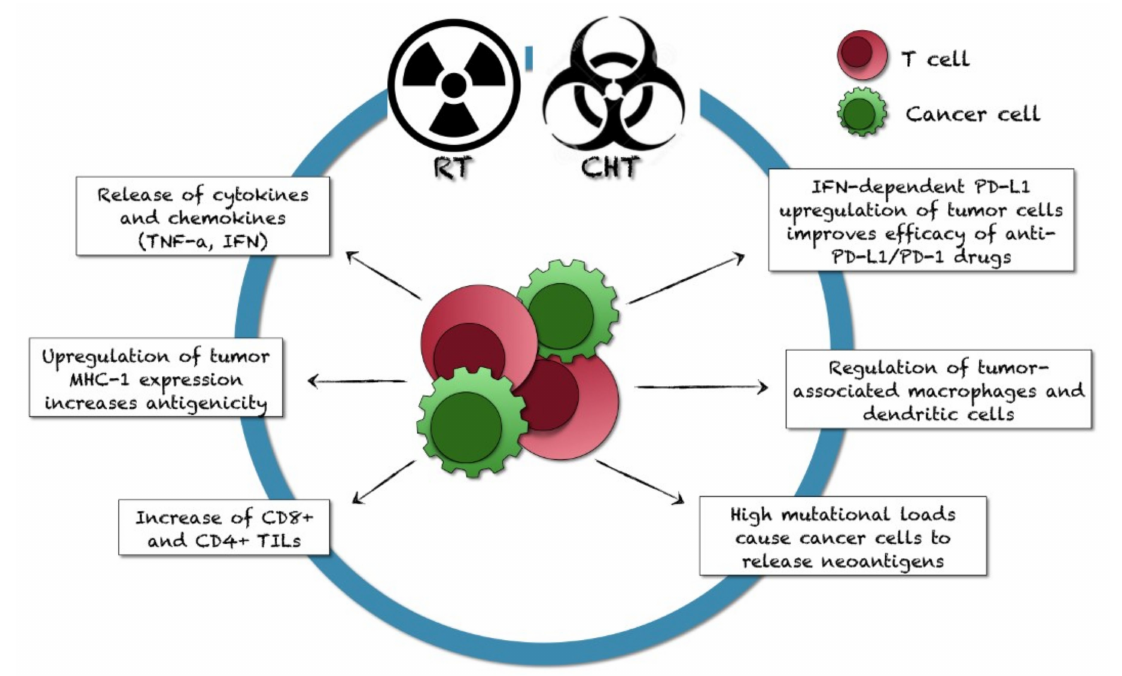
Figure 5. Potential immunogenic effects of Radiotherapy (RT) and/or Chemotherapy (CHT) on tumor cells (IFN: interferon; MHC: major histocompatibility complex; TILs: tumor-infiltrating lymphocytes; TNF: tumor necrosis